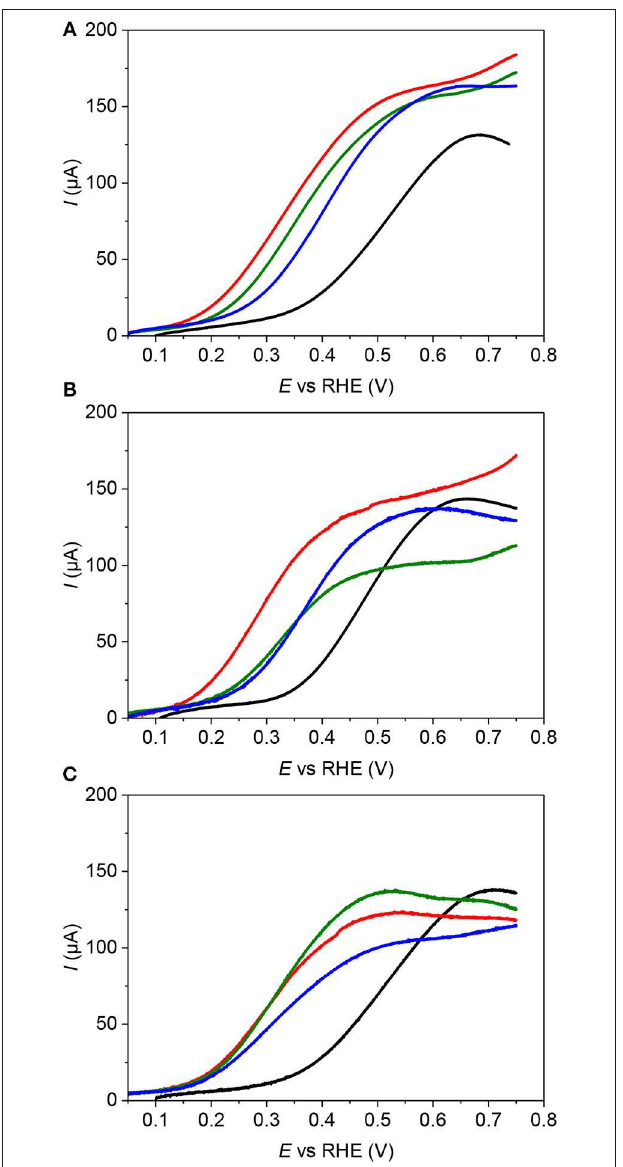
FIGURE 5 | Polarization curves recorded for the electrooxidation of glucose 10 − 1 mol L − 1 in NaOH 10 − 1 mol L − 1 aqueous electrolyte (T = 293K, scan rate = 5mV s − 1 ) on Au-modified Pd-NPs by dipping 1min in HAuCl 4 solutions. (A) Pd-NS, (B) Pd-NC, and (C) Pd-NO. – for pure Pd-NPs, – after dipping 1min in HAuCl 4 0.01M, – after dipping 1min in HAuCl 4 0.10M and – after dipping 1min in HAuCl 4 1.00M.